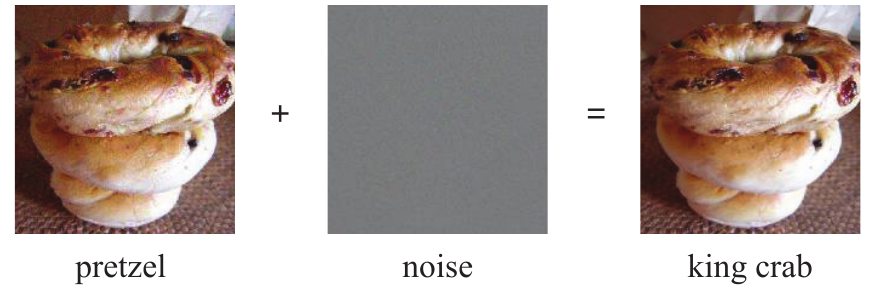
Figure 2. Flowchart of the generation of adversarial samples. After adding almost invisible noise to the image of a pretzel, the AI model adjudicates with a high degree of confidence as a king